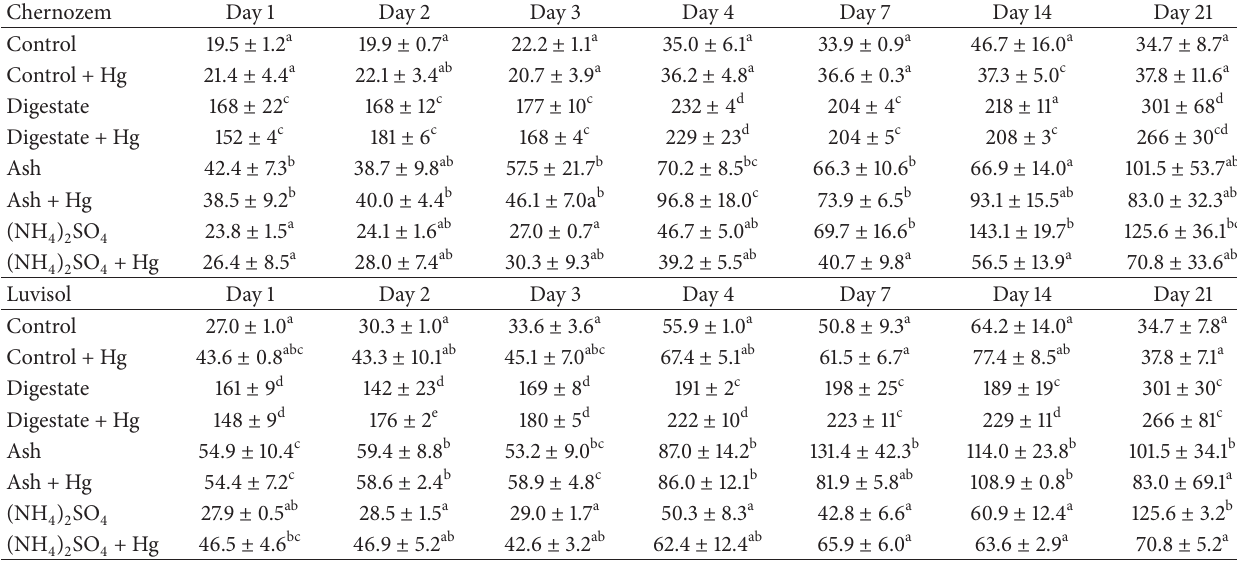
Table 8: The concentrations of Mn extractable with 0.11mol L − 1 acetic acid within the incubation experiment (mg ⋅ kg − 1 ); the averages marked by the same letter did not significantly differ at 𝑃 < 0.05 within individual columns; data are presented as mean ± standard deviation ( 𝑛 = 3